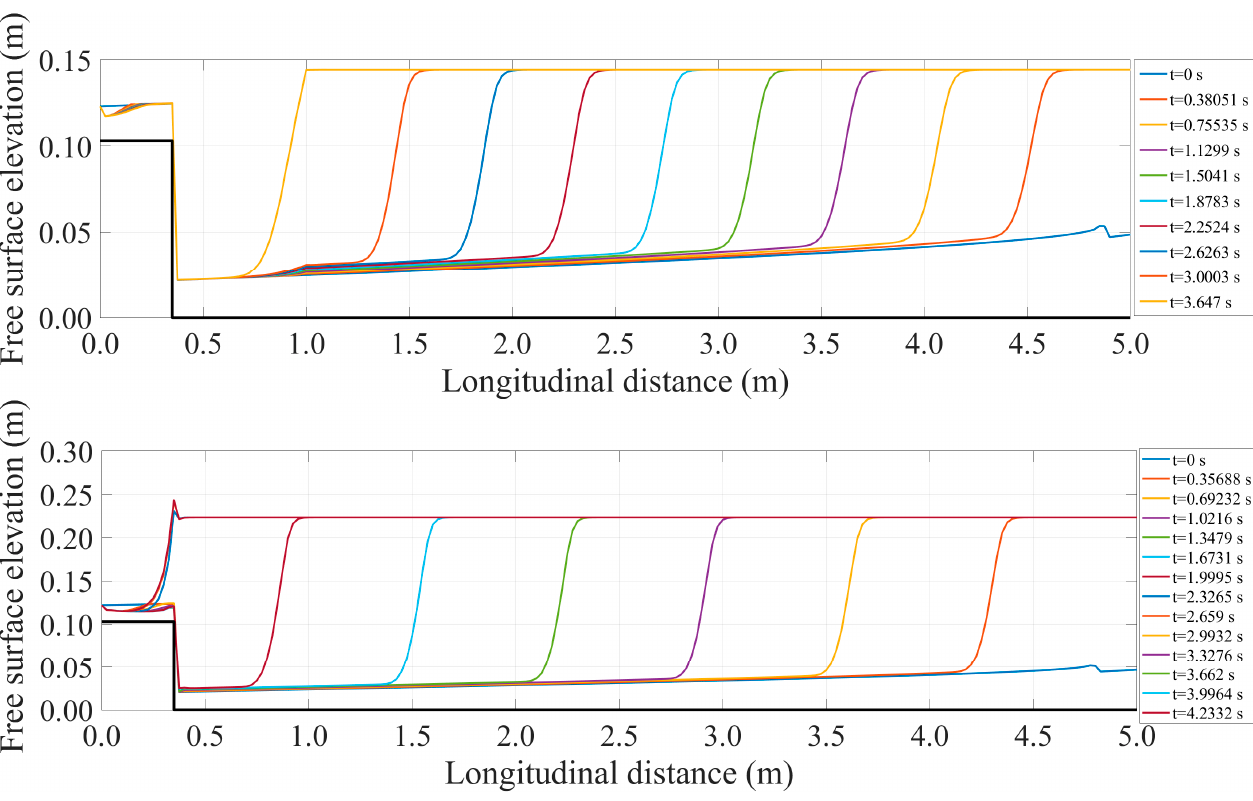
Figure 16. Numerical results for the temporal evolution of the jump: Test case 2 ( top ) for the Dissipative Two-Four scheme, and test case 4 ( bottom ) for the MacCormack scheme. Table 3. Mass balance error and number of iterations for convergence.